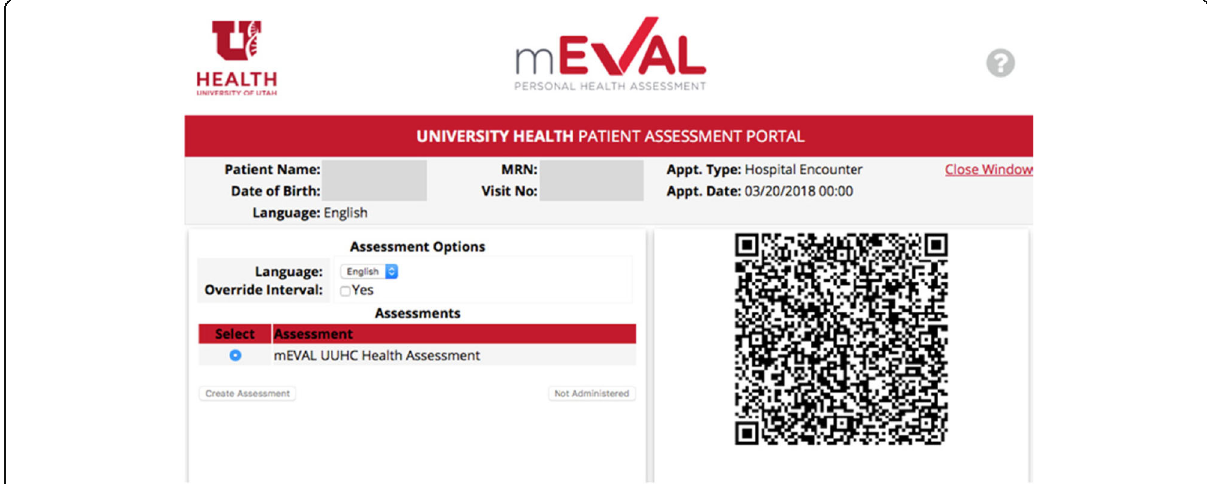
Fig. 1 mEVAL Portal Used by Staff to Sign Patients in to the mEVAL